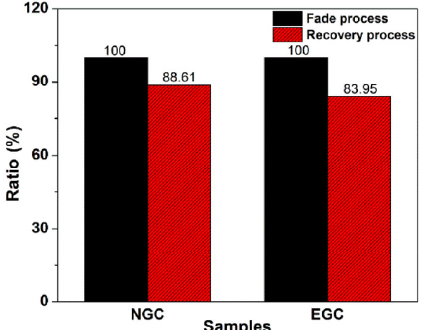
Fig. 5 Fade ratio and recovery ratio of the friction materials.